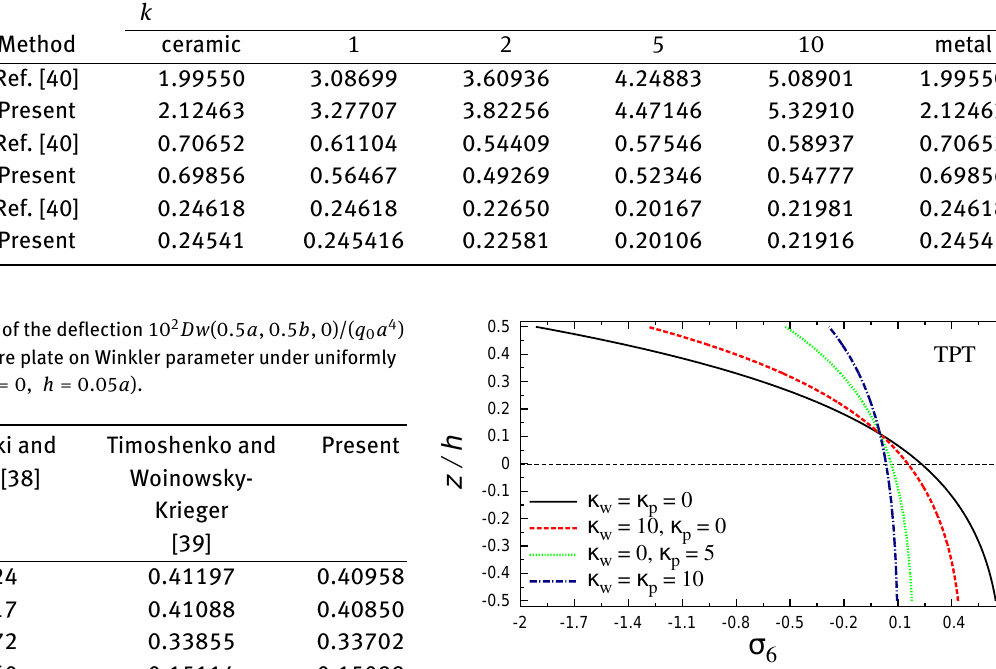
Figure 6: Through-the-thickness distributions of stress σ 6 of the EG thick rectangular plate on elastic foundations ( b = 3 a , a = 4 h , k = 1.5) .